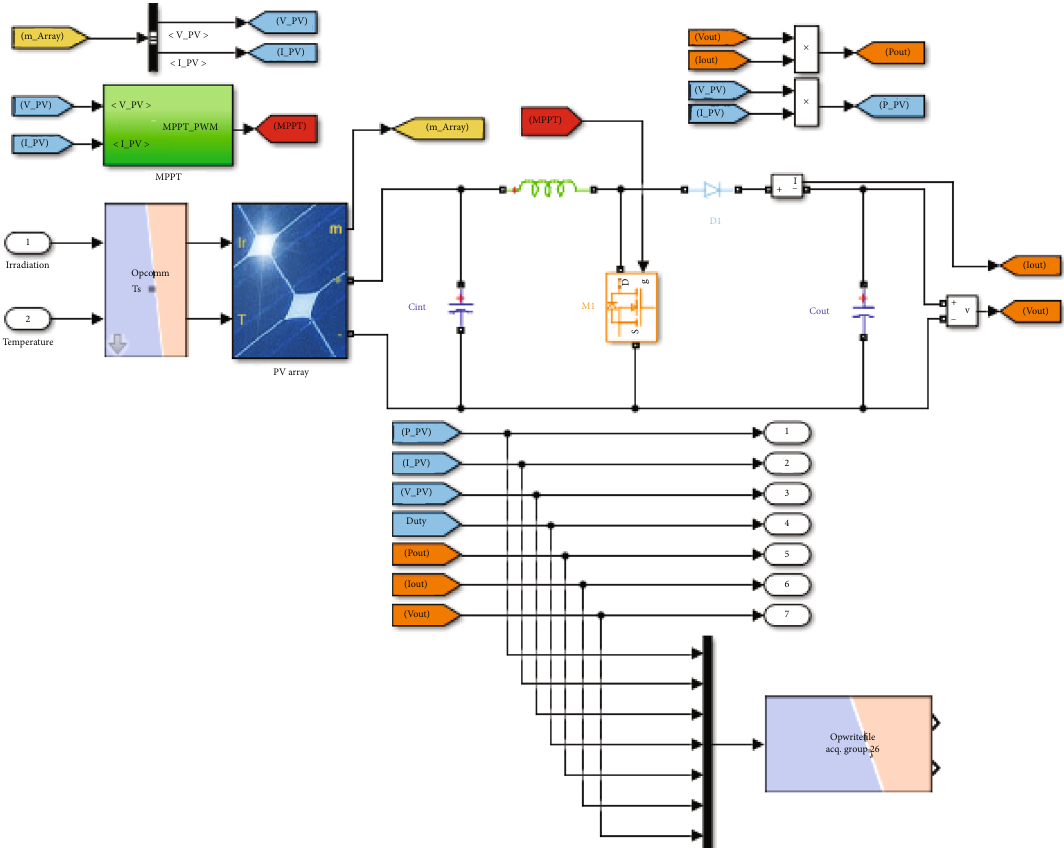
Figure 23: Contents of the SM subsystem